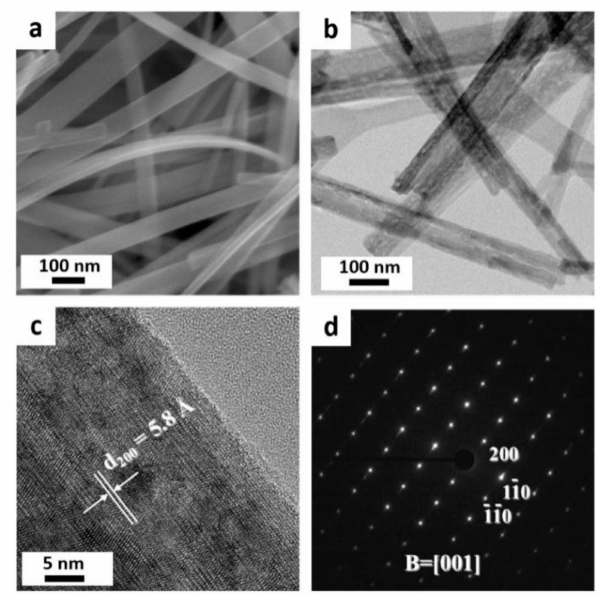
Figure 3. ( a ) Low magnification field-emission scanning electron microscopy (FESEM) and ( b ) TEM image of mesoporous TiO 2 -B nanobelts, ( c ) high resolution TEM (HRTEM) image of one single nanobelt, showing the fringe spacing of crystalline TiO 2 -B and ( d ) the corresponding electron di ff raction (ED)